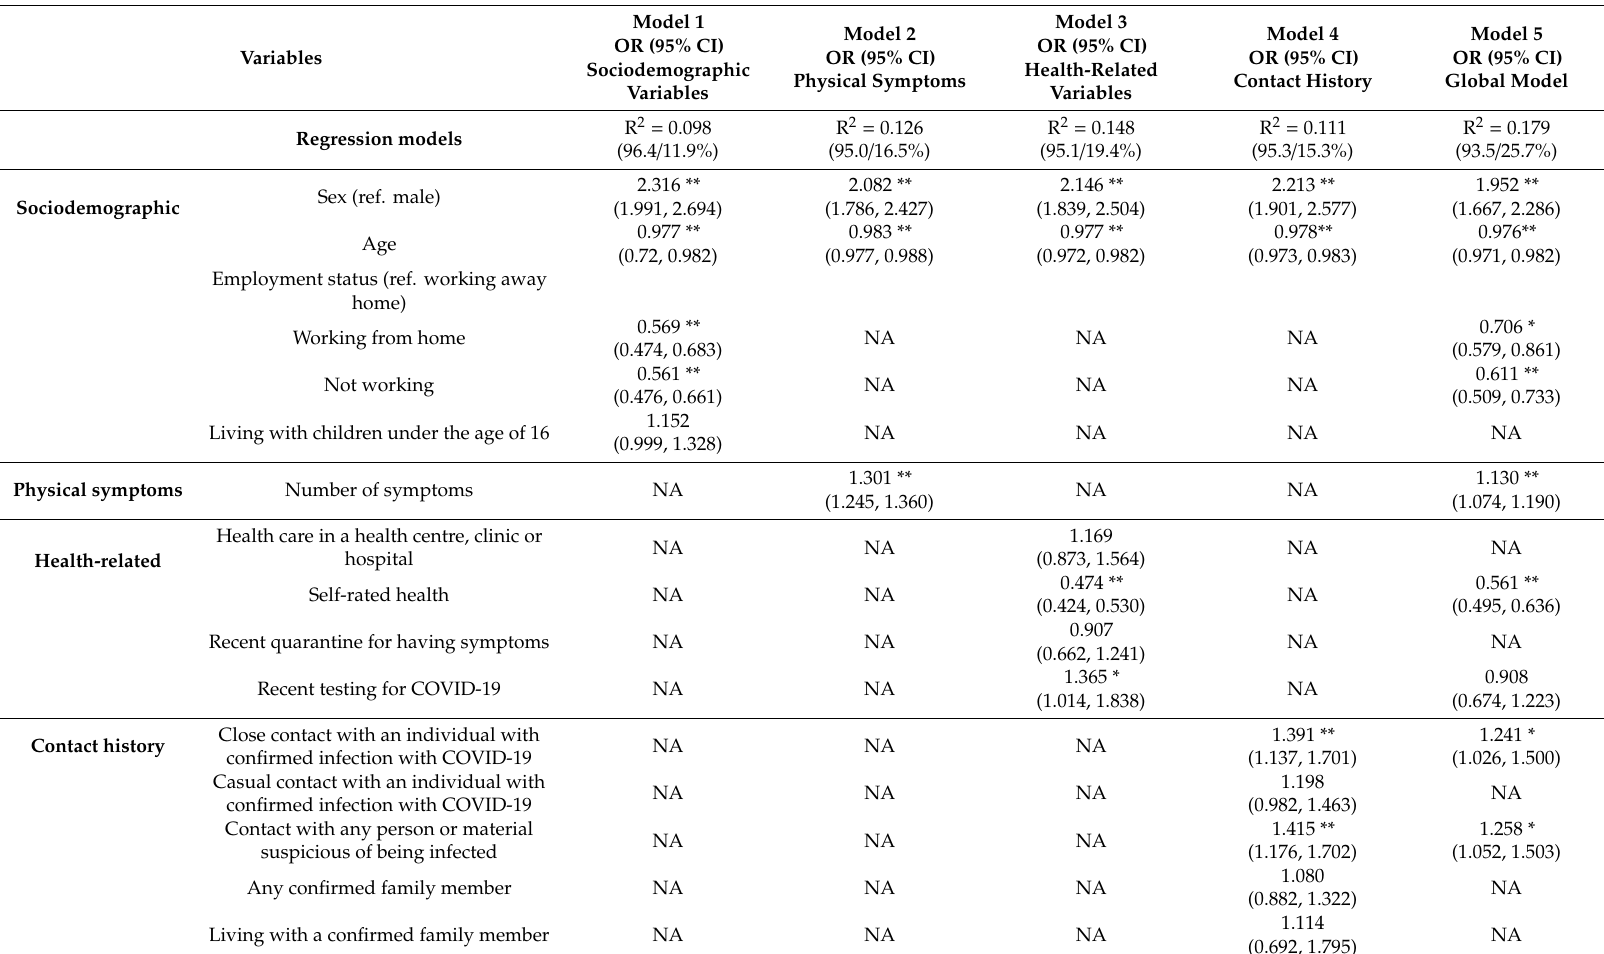
Table 6. Logistic regression models on psychological distress by set